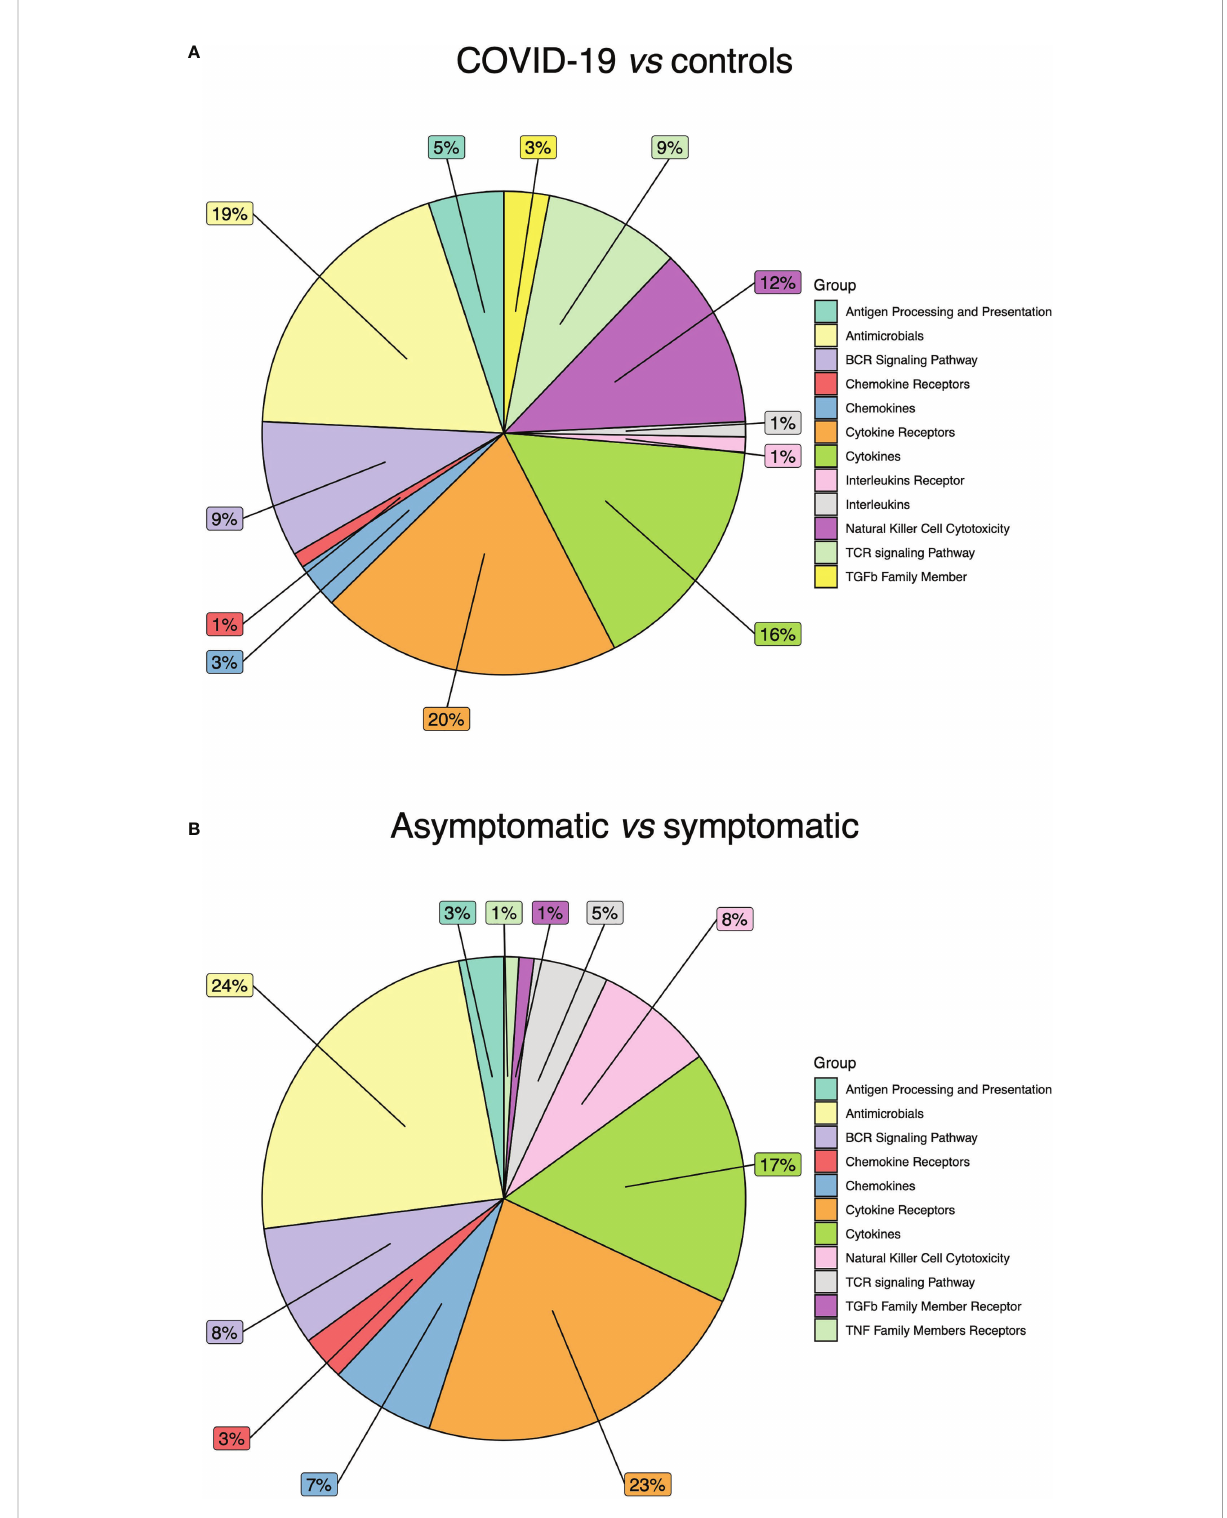
FIGURE 3 Immune related gene categories affected by DNA methylation alterations. (A) Pie chart showing the percentage of DNA methylation alterations in COVID-19 patients vs controls. (B) Pie chart showing the percentage of DNA methylation alterations in COVID-19 asymptomatic vs symptomatic